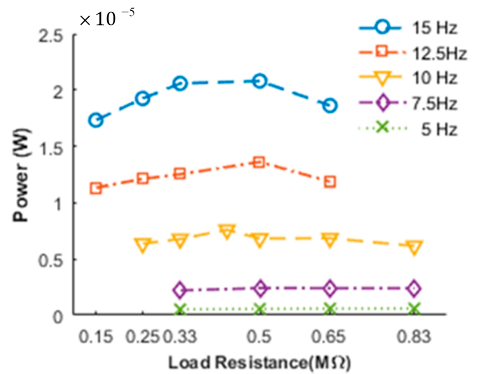
Figure 9. The RMS output power versus load resistance for different frequencies.